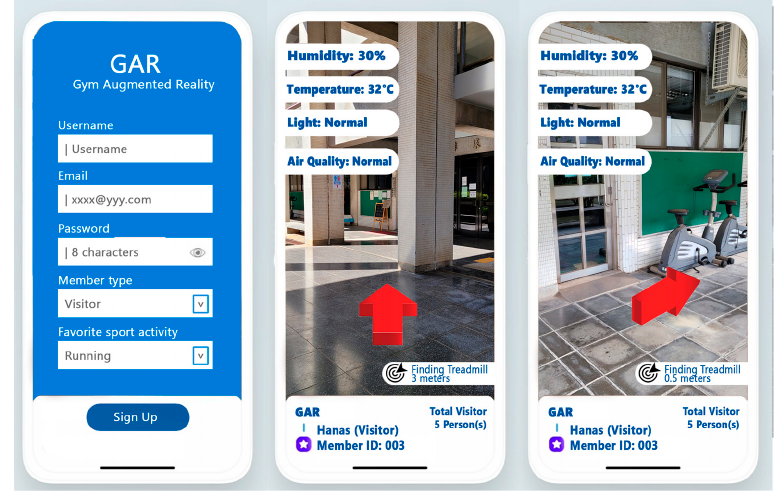
Figure 17. Device screen mode: screenshots of the registration page ( left ), main page when far from gym equipment ( middle ), and main page when near gym equipment ( right ).